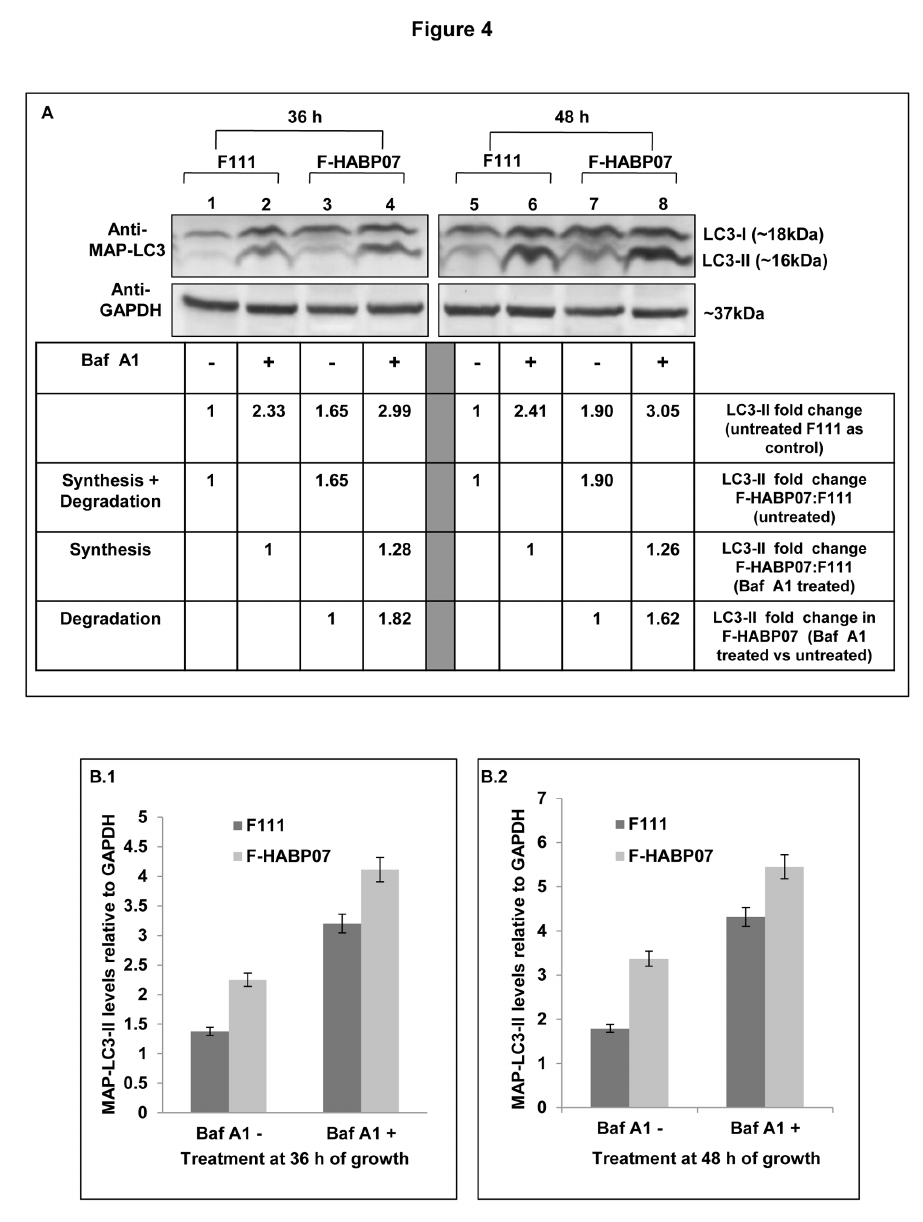
Figure 4. Increased autophagic flux or lysosomal proteolysis upon HABP1 overexpression verified by Baf A1 treatment. [A] Immunoblotting of Baf A1 treated cells reveal both synthesis and degradation in F-HABP07 -- Lysosomal proteolysis was inhibited by Baf A1 (50nM) treatment at 36 h (Lane 1-4) and 48 h ((Lane 5-8)) and changes in MAP-LC3-II levels were observed in both treated (6 h) and untreated F111 and F-HABP07 cells in order to access autophagic degradation. After normalization with GAPDH fold change of MAP-LC3-II (16kDa) was calculated taking its expression in untreated F111 as control, using ImageJ. Amount of synthesis plus degradation upon HABP1 overexpression was measured from the untreated controls i.e. Lane 3 vs Lane 1 (36 h) and Lane 7 vs Lane 5 (48 h). This revealed increased expression in F-HABP07 compared to F111 cells, during 36 and 48 h of growth as per the earlier observation. Comparison between the Baf A1 treated samples i.e Lane 4 vs Lane 2 (36 h) and Lane 8 vs Lane 6 (48 h) gave an idea about autophagosome synthesis. It indicated an augmented synthesis of autophagosome in F-HABP07 cells. Increased autophagic flux or degradation in F-HABP07 is divulged from fold increase in MAP- LC3-II expression in Baf A1 treated and untreated cells i.e Lane 4 vs lane 3 (36 h) and Lane 8 vs Lane 7 (48 h). The fold changes have been indicated in a tabulated form. [B] Graphical representation of fold changes -- The fold changes for MAP-LC3-II expression after normalization with GAPDH in Baf A1 treated (Baf A1 +) and untreated (Baf A1 -) F111 and F-HABP07 cells have been represented graphically for both 36 h ( B .1) and 48 h ( B .2). doi: 10.1371/journal.pone.0078131.g004 PLOS ONE |